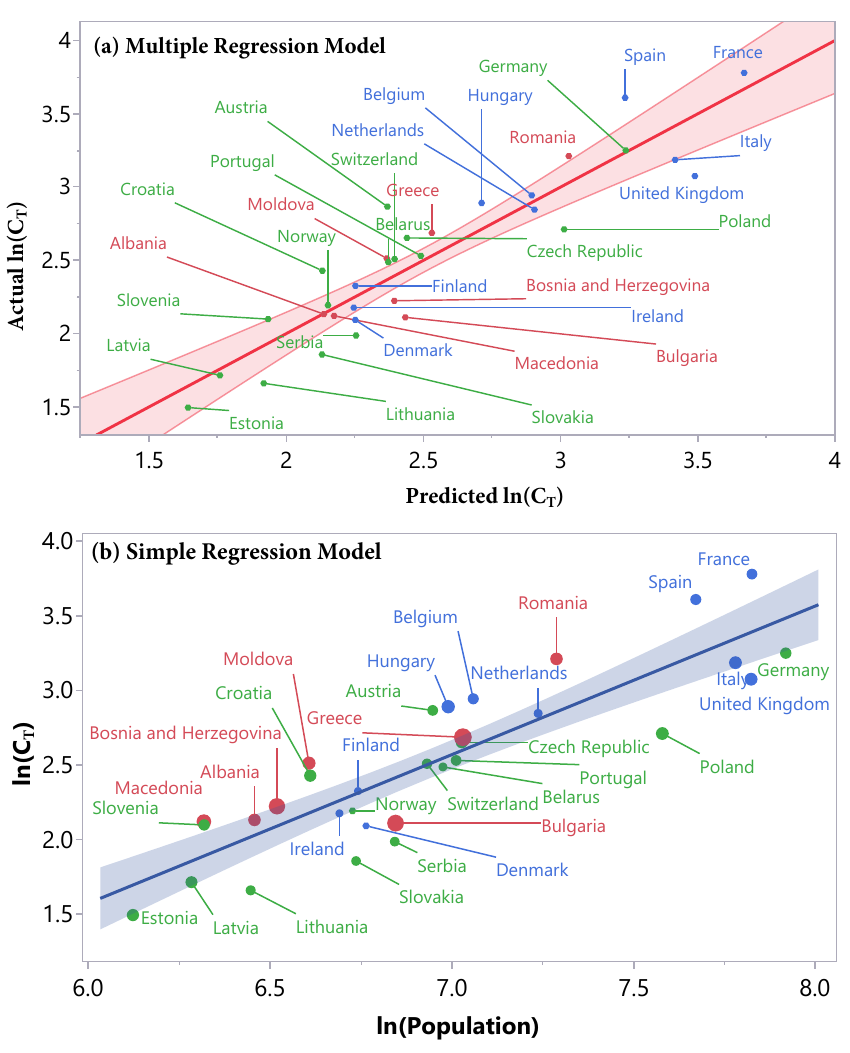
diagonal line, the better the model fits the data. The results of the t -tests for every parameter in the model are displayed in Table 5.